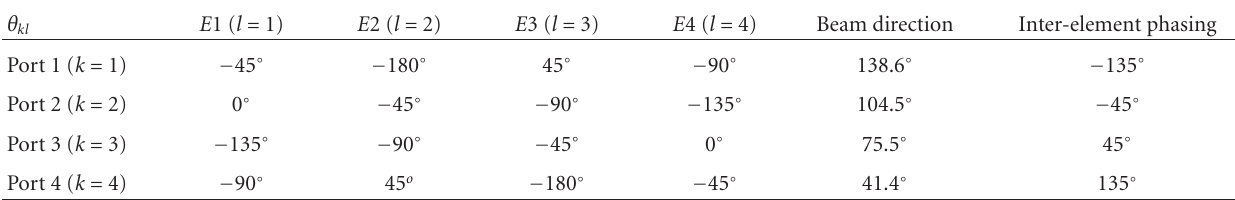
Table 1: Element phasing, beam direction, and interelement phasing for the Butler matrix shown in Figure 3 (conceptual).